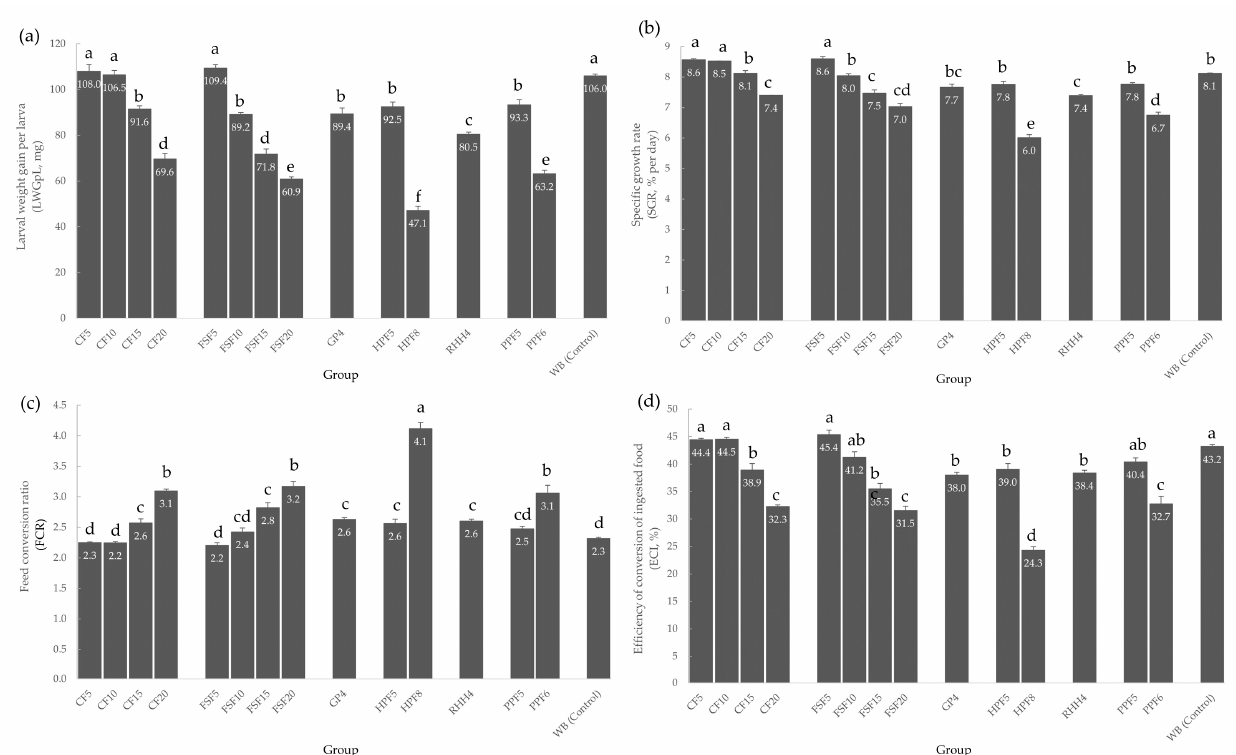
Figure 1. ( a ) Larval weight gain per larva, ( b ) specific growth rate, ( c ) feed conversion ratio, and ( d ) efficiency of conversion of ingested food of Tenebrio molitor larvae from different feeding groups; CF5: coconut flour and wheat bran (5% fat); CF10: coconut flour and wheat bran (10% fat); CF15: coconut flour and wheat bran (15% fat); CF20: coconut flour and wheat bran (20% fat); FSF5: flaxseed flour and wheat bran (5% fat); FSF10: flaxseed flour and wheat bran (10% fat); FSF15: flaxseed flour and wheat bran (15% fat); FSF20: flaxseed flour and wheat bran (20% fat); GP4: grape pomace and wheat bran (5% fat); HPF5: hemp protein flour and wheat bran (5% fat); HPF8: hemp protein flour and wheat bran (8% fat); RHH4: rose hip hulls and wheat bran (4% fat); PPF5: pea protein flour and wheat bran (5% fat); PPF6: pea protein flour and wheat bran (6% fat); and WB: wheat bran (control). Differences between treatments ( p < 0.05) are indicated by different letters, results are given as the mean ± standard deviation, n = 5.